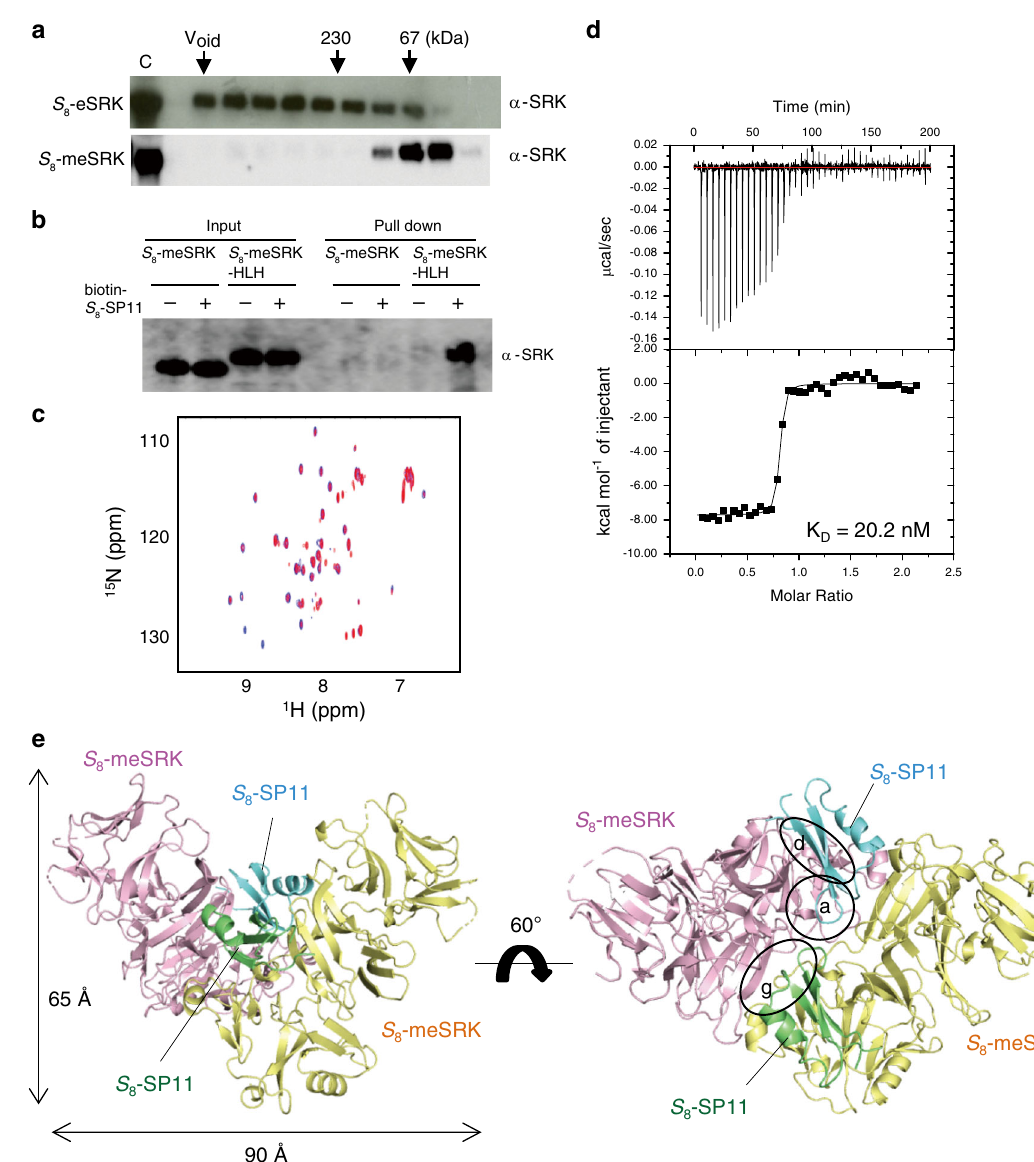
Fig. 1 Structure determination of S 8 -meSRK – S 8 -SP11 complex. a Eleven amino acid mutations of S 8 -eSRK ( S 8 -meSRK) suppress self-aggregation. The immunoblots show the fractions from size exclusion chromatography of S 8 -eSRK and S 8 -meSRK ectodomains expressed in insect cells. Arrows show the elution positions of molecular mass markers. C, control supernatants of insect cell culture expressing the recombinant proteins. b S 8 -meSRK possesses S 8 - SP11 recognition activity. The panel shows immunoblot analysis of pull-down eluates using biotin- S 8 -SP11 and insect culture media expressing S 8 -meSRK or S fi cial fusion with the dimerization domain of a bHLH-ZIP protein 18 . c Chemical shift perturbation analysis of S 8 -meSRK-HLH, which is an arti Overlay of the spectrum of 15 N-labeled S 8 -SP11 (blue) with that of 15 N-labeled S 8 -SP11 co-existing with unlabeled S 8 -meSRK (red). d ITC analysis of the S 8 - meSRK – S 8 -SP11 interaction. Upper panel, thermogram; lower panel, integrated titration curve. e Overall structure of S 8 -meSRK – S 8 -SP11 heterotetramer. Two S 8 -meSRK (pink and yellow) and two S 8 -SP11 (cyan and green) molecules are shown as cartoon models. Dotted lines indicate disordered regions. Details of the labeled circles are shown in Fig. 2a, d,